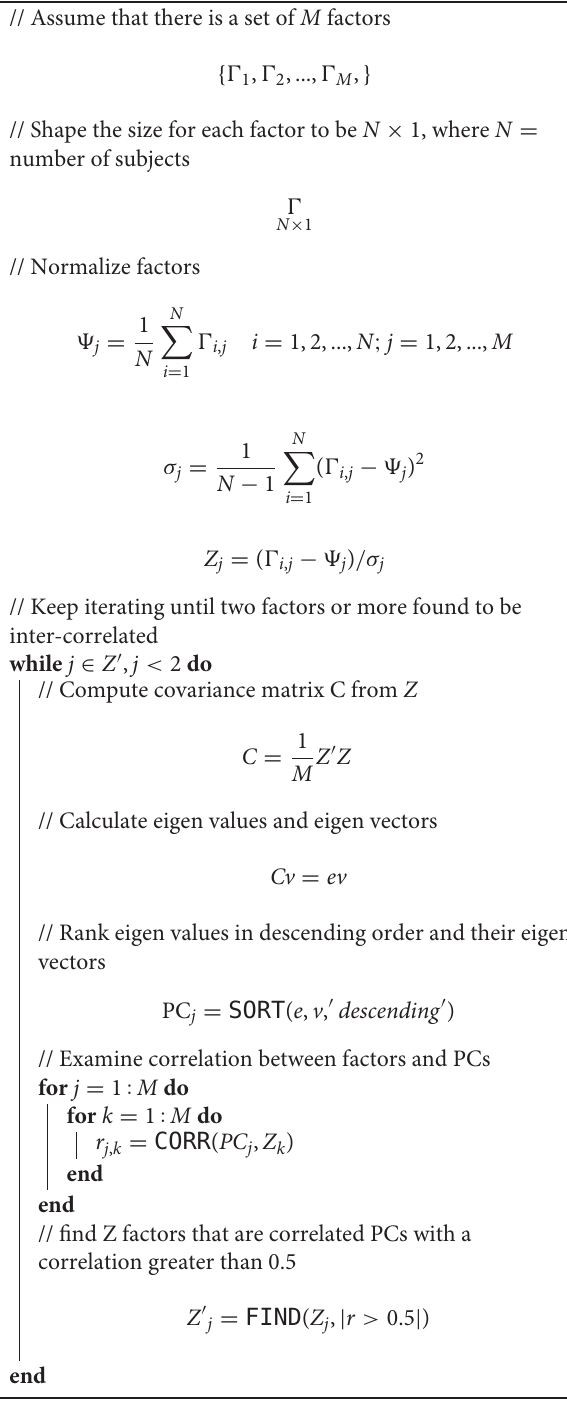
Algorithm 1: Interaction Principal Component Analysis